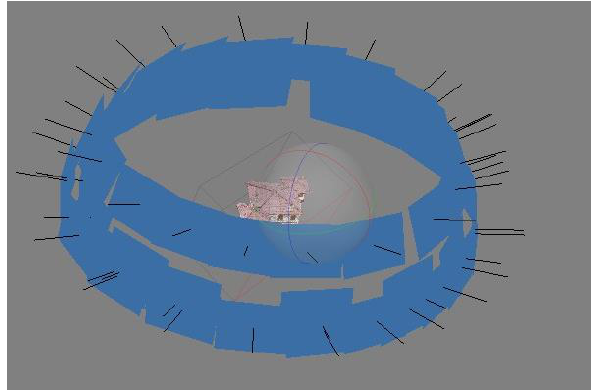
Figure 6: 2 strips of images captured